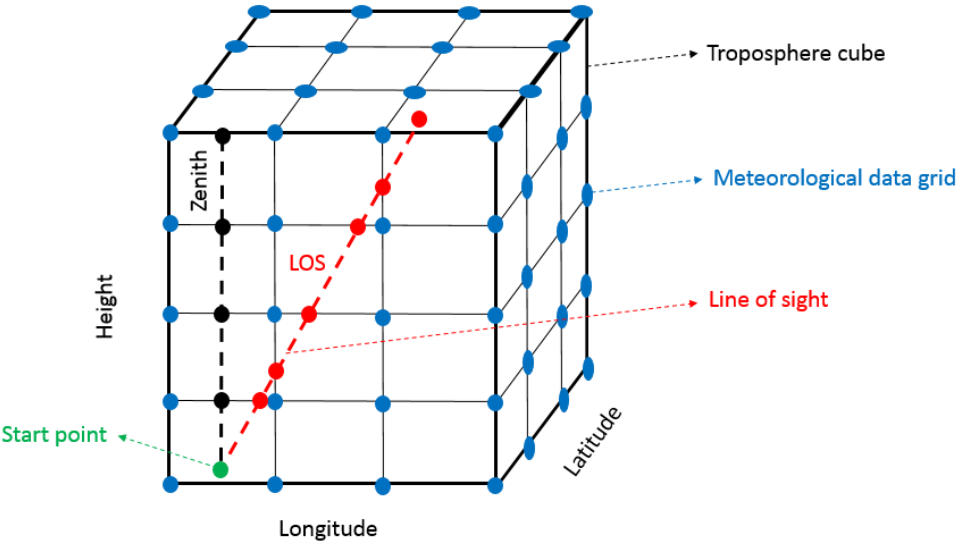
Figure 1. Simple and advanced integration techniques for tropospheric delay computation .